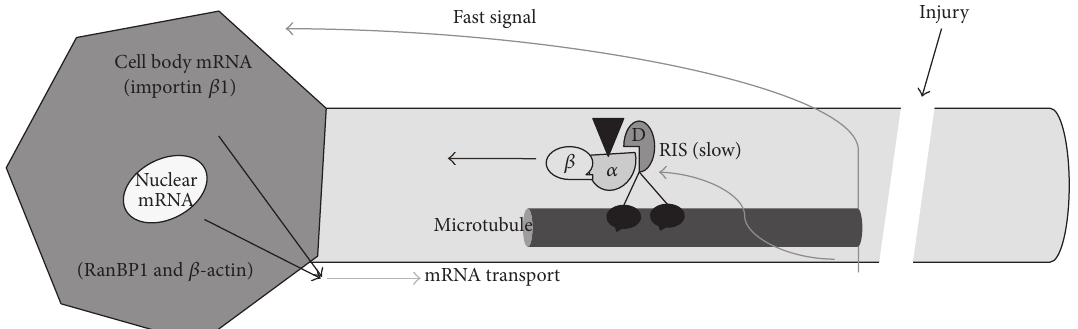
Figure 7: Schematic representation of biphasic axonal response to injury. Upon injury, a fast signal and slower RIS complex transported signal differentially regulate the levels of several transcripts. Changes in axonal protein levels occur over period of 6 hrs, suggesting the dynamic formation of RIS complexes. We posit that the transported RIS complex, via importin 𝛽 -mediated nuclear import, triggers the delayed/second wave of transcriptional changes in the